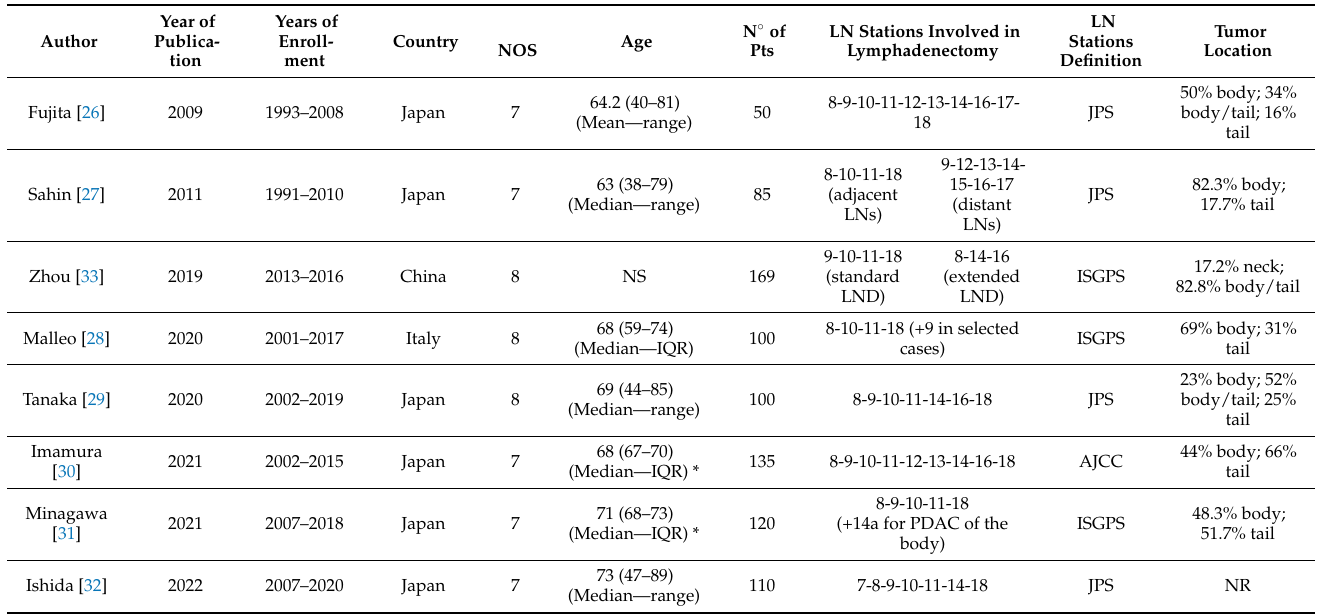
Table 1. Characteristics of included studies. NS: not specified; * computed using the quantile estimation (QE) method [37].